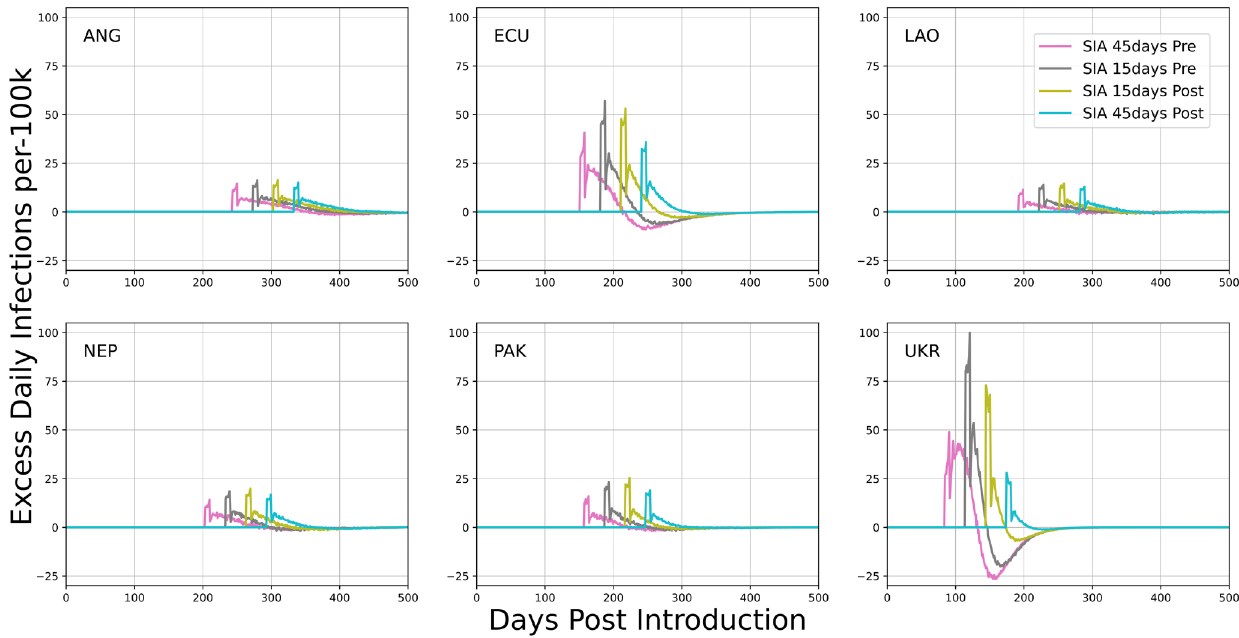
Figure 3. Mean excess daily SARS-CoV-2 infections per 100k individuals in each country examining fixed-post SIAs in urban simulations. Scheduling of SIAs is with respect to the time of peak incidence. The x-axis describes the number of days post SARS-CoV-2 introduction to the